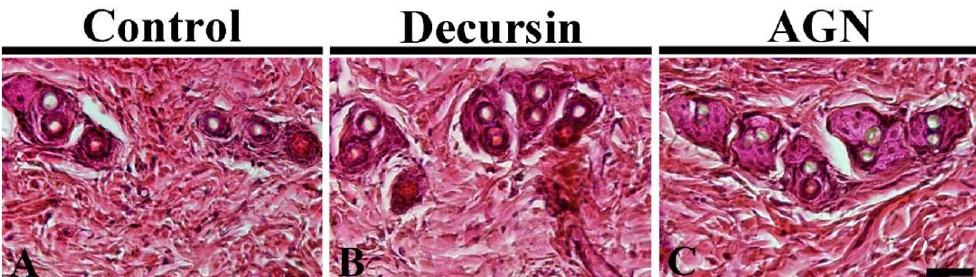
Figure 3. H and E staining in the dorsal skin of the control ( A ), decursin ( B ) and AGN ( C ) groups at 17 days after topical application of DW, decursin and AGN, respectively. There is no significant difference in the histology stained with H and E among the three groups ( n = 10 in each group). Scale bar = 40 μm.